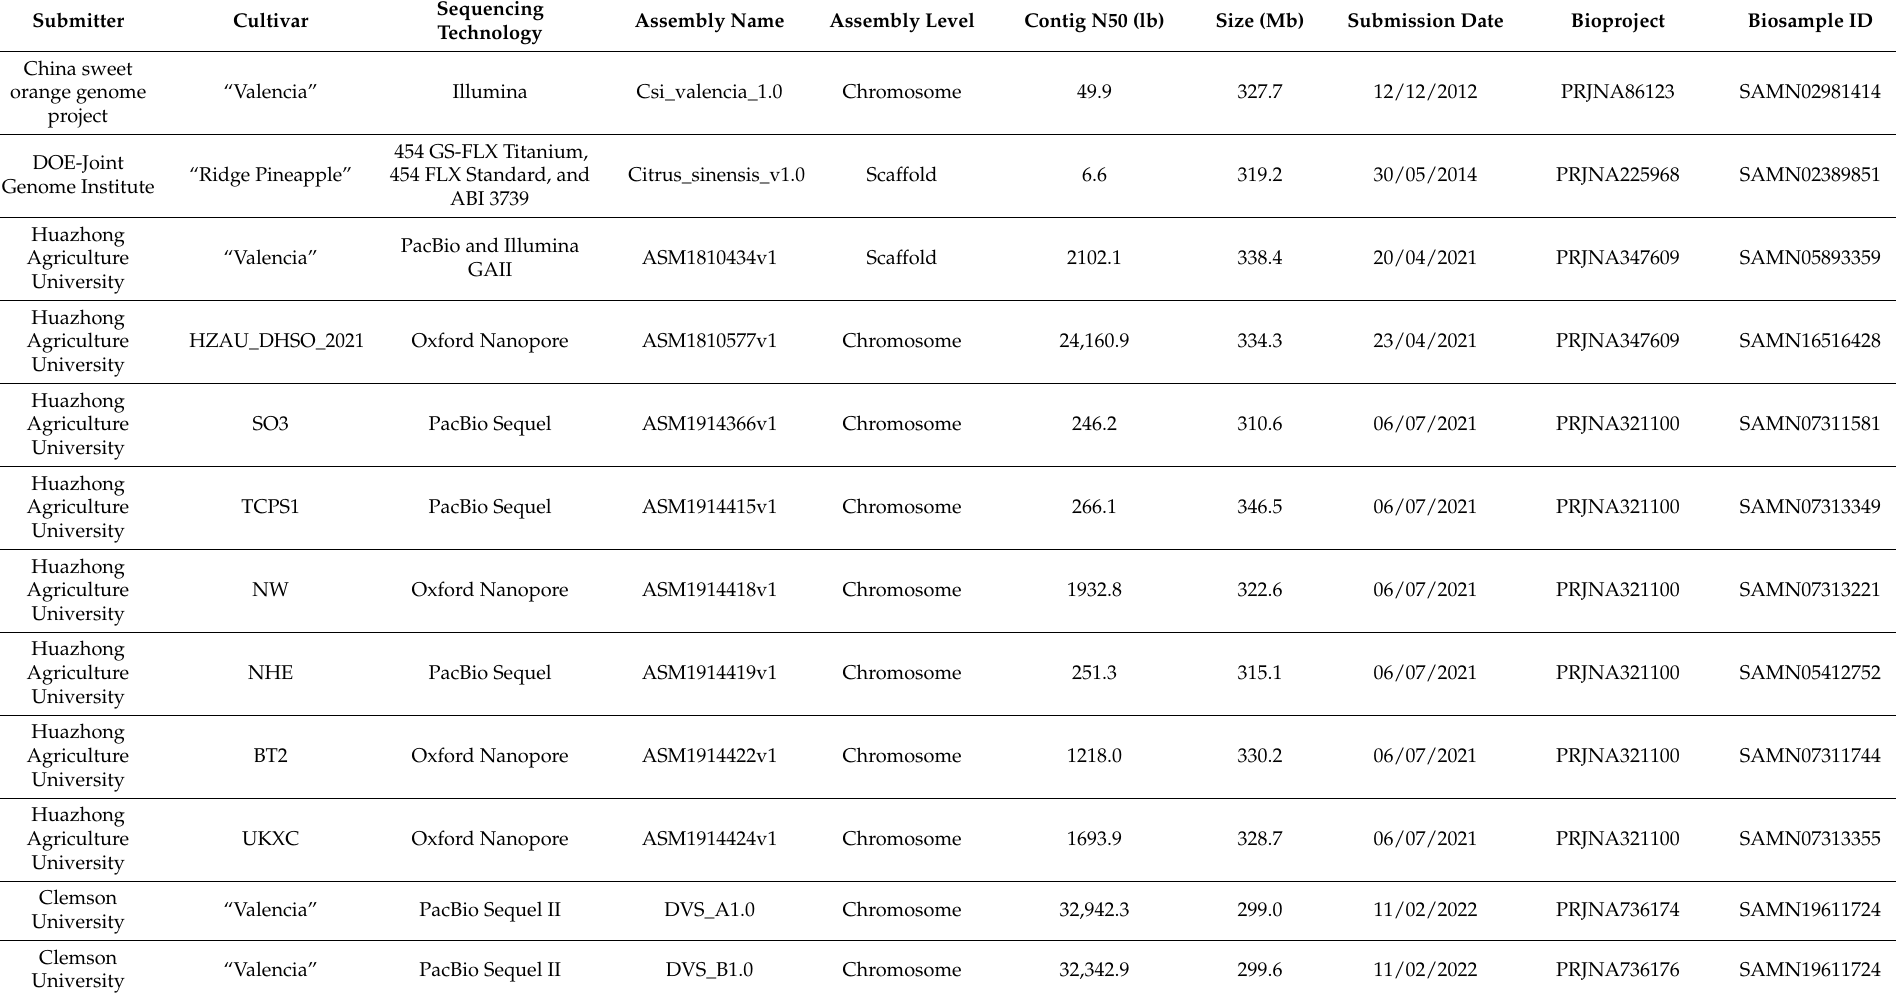
Table 5. Features of the released Citrus sinensis sweet orange